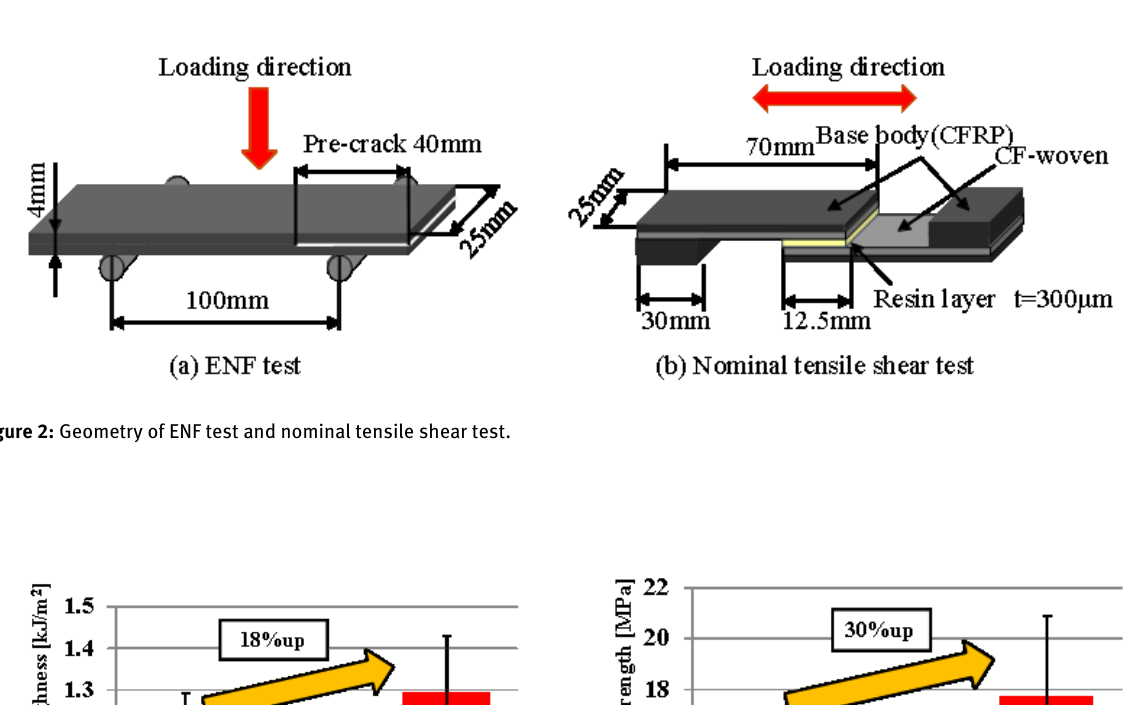
Figure 1: Fabrication processes for changing the locational states of submicron fibers.